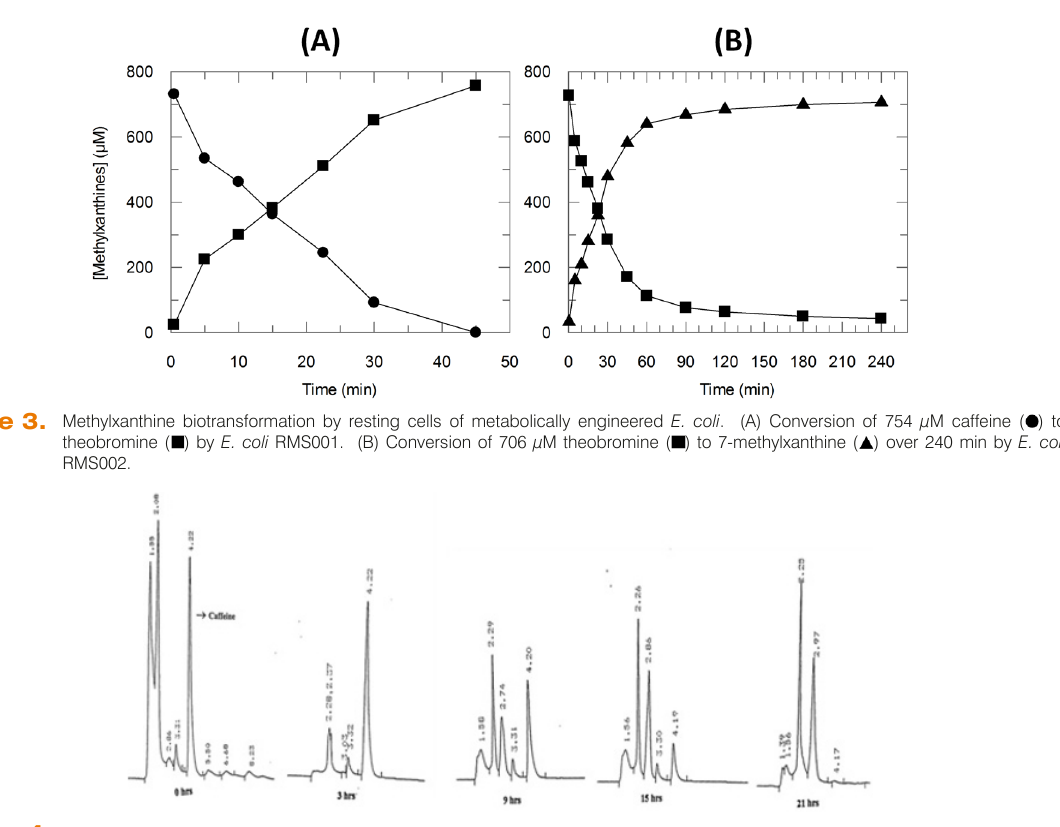
Figure 4. HPLC profile of decaffeination of tea extract by immobilized mixed culture of Klebsiella and Rhodococcus cells. Caffeine eluted from the column in 4.2